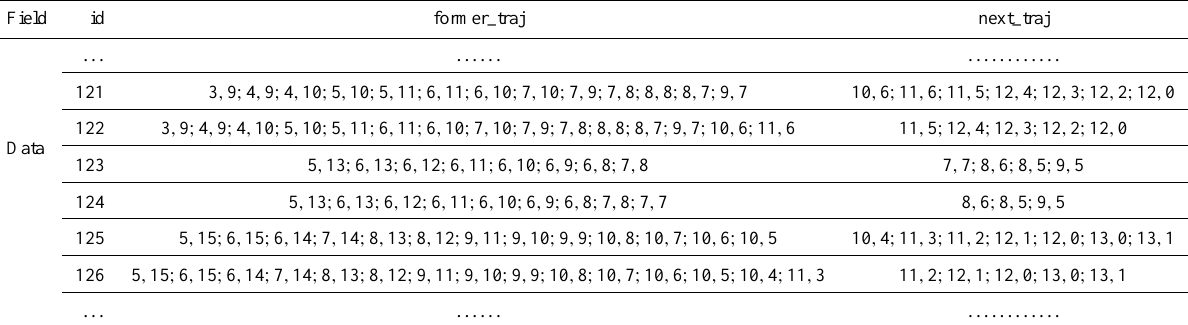
Table 3. The datum in experiment_data